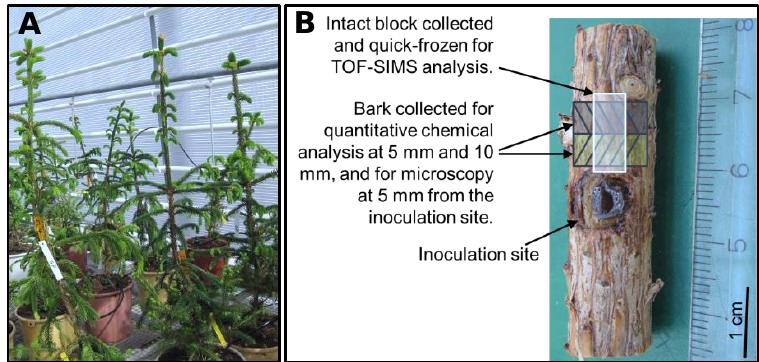
Figure 1. Saplings in the greenhouse experiment ( A ) used to study the wounding and fungal inoculation-induced responses in terms of the amounts and localization of (+)-catechin, stilbene glucosides, and resin acids within the phloem. Stem section containing the inoculation site ( B ) and a schematic presentation of tissue positions from which the specimens for chemical and anatomical analyses of the phloem were collected.